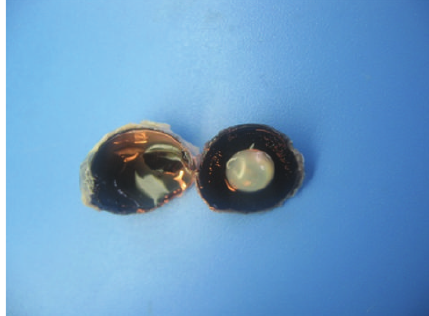
Figure 2: The appearance of pecten oculi of the